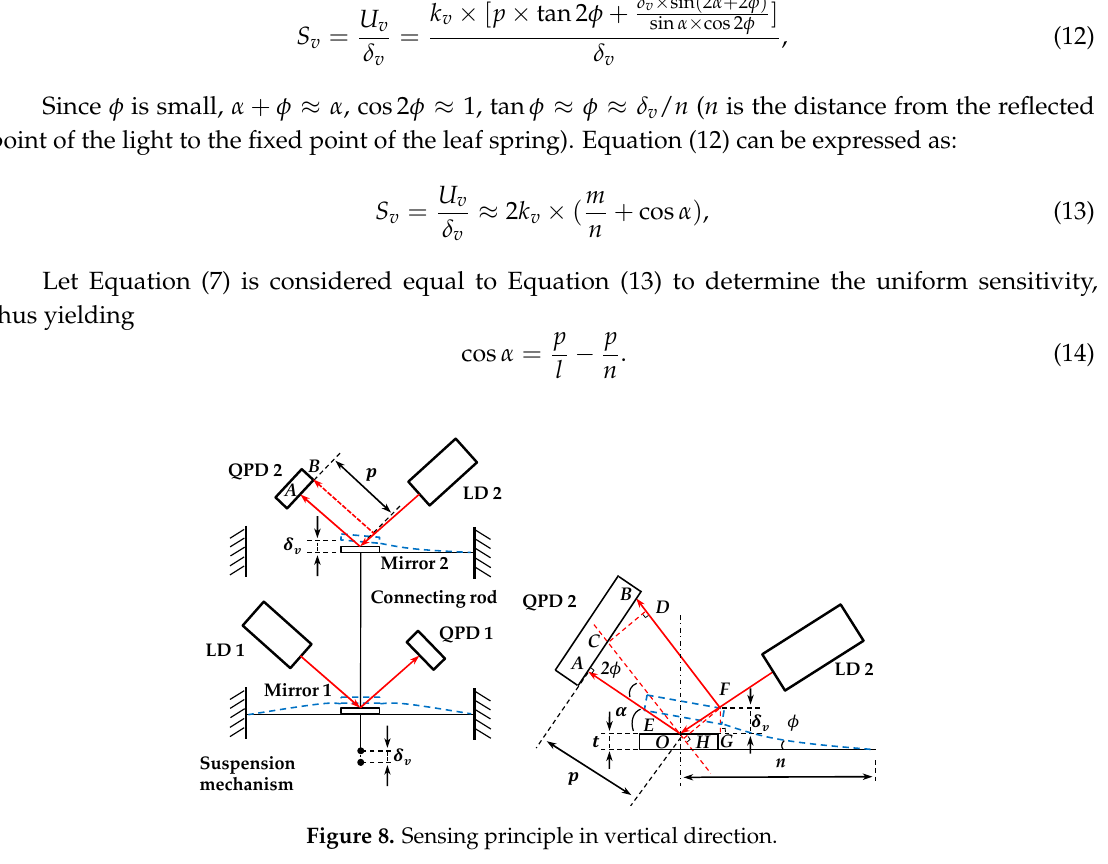
Figure 8. Sensing principle in vertical direction.